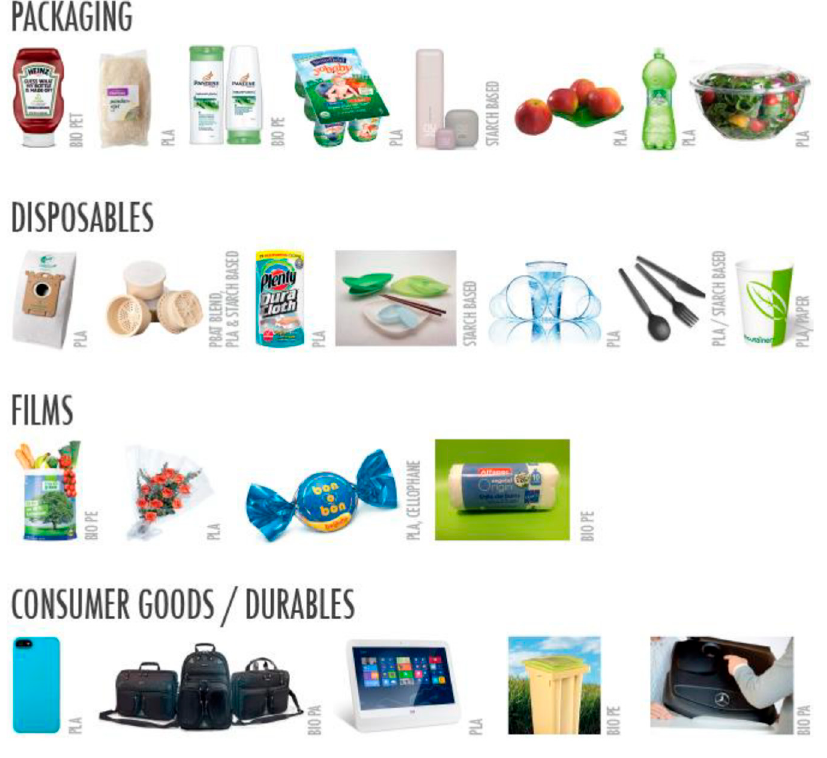
Figure 8 : Bio-based plastic products. Figure 8. Bio-based plastic products.